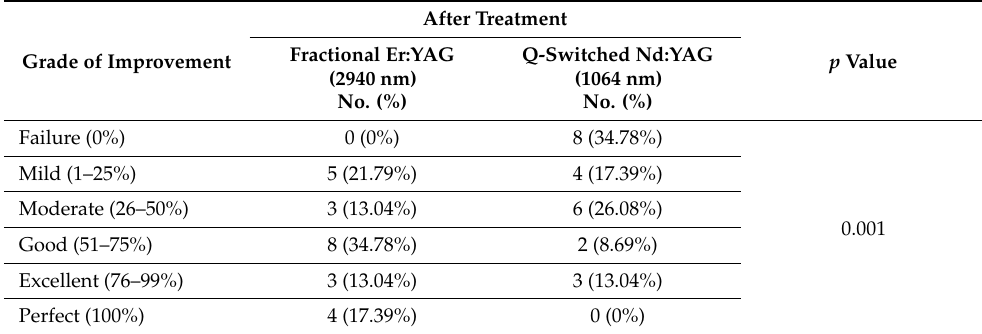
Table 3. The grade of improvement between Q-switched Nd: YAG (1064 nm) and fractional Er: YAG (2940 nm) lasers after treatment.